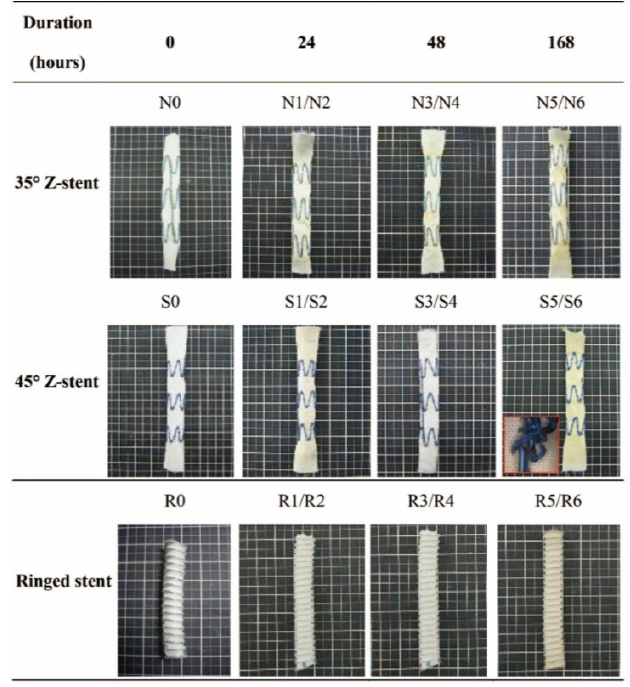
Figure 4. Gross observations after twisting tests. The fabrics of the polyester conduits are without visible holes. However, some sutures are fractured in the Z ‐ stent devices and one vertical strut of a 45° Z ‐ stent is fractured after 168 h of accelerated testing.